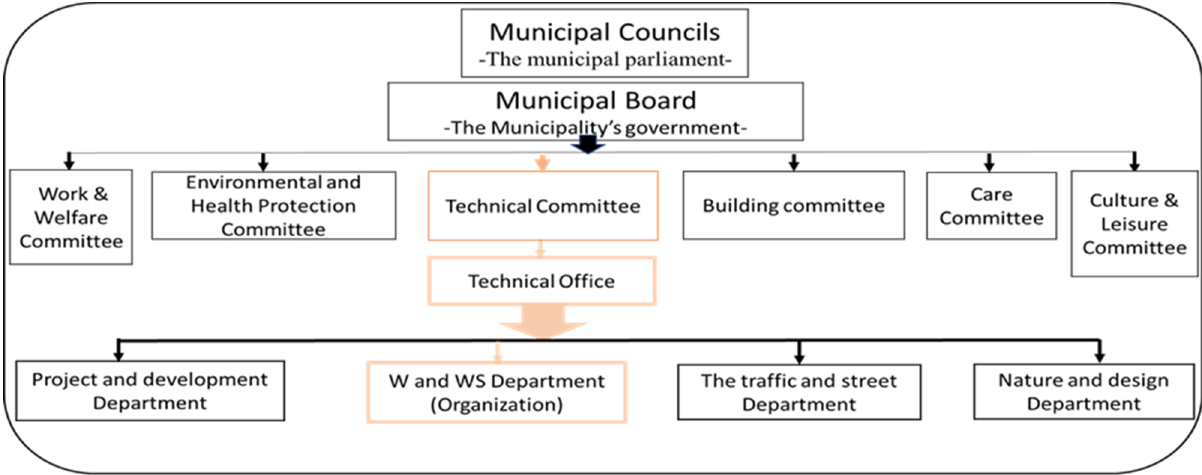
Figure 12. Committees that are part of the municipal structure. Highlighted in pink is the structure of the traditional form of the W and WS organization.